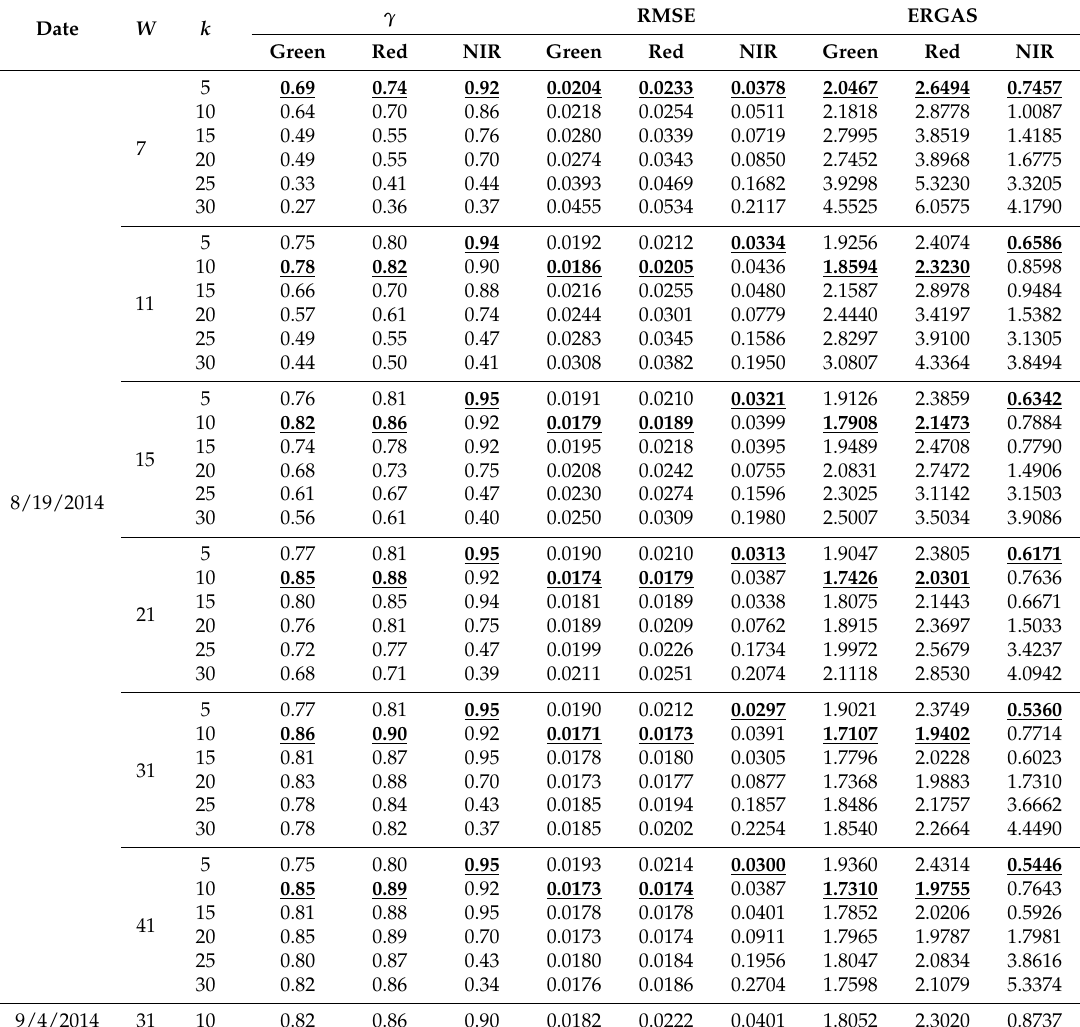
Table 2. The accuracy of MODIS unmixing data on 19 August and 4 September 2014 at different combination of window size scales W and class number k